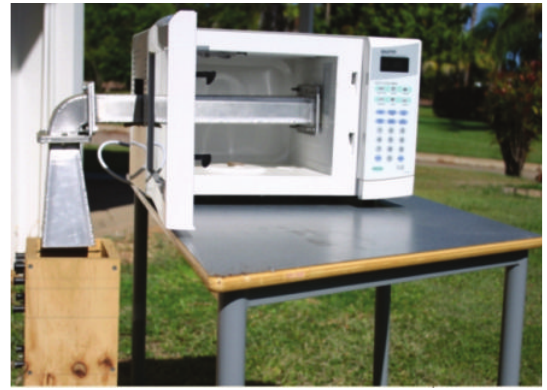
Figure 2: A laboratory prototype system based on a modified mi- crowave